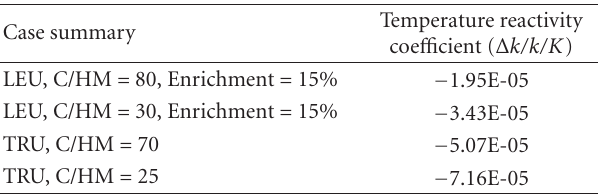
Table 6: Lifetime of VHTRs with TRUs ∗ .